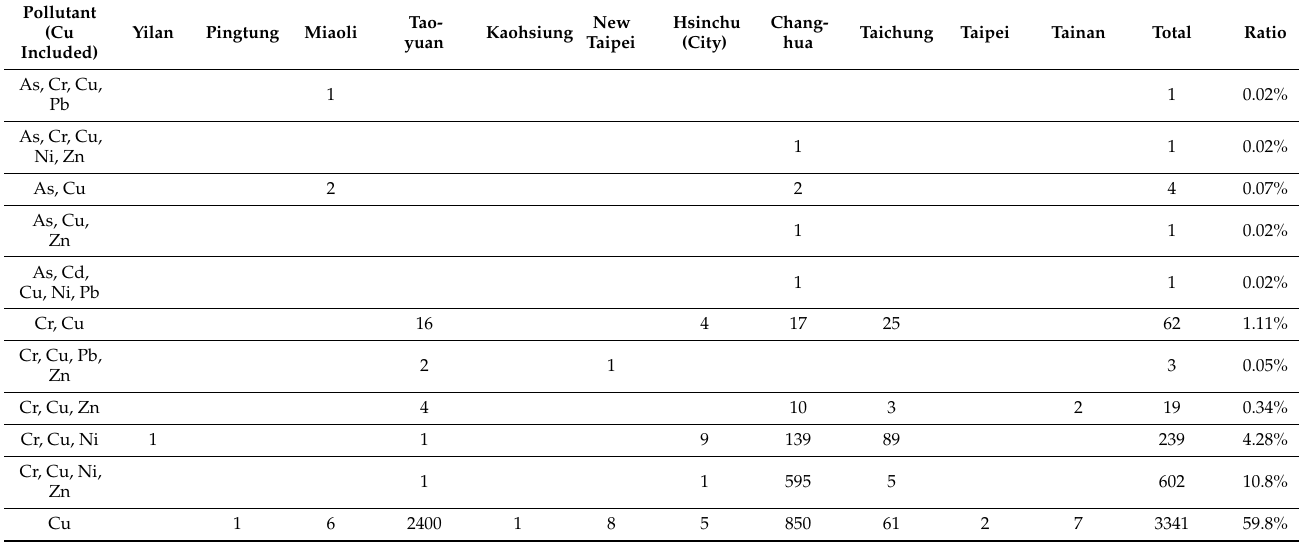
Figure 5. Heavy metal statistics of irrigation canals in Taiwan. The number in the parentheses is the number of metal appearance in the sampled irrigation canals. Table 2. Summary of pollution characteristics in agricultural land pollution sites containing